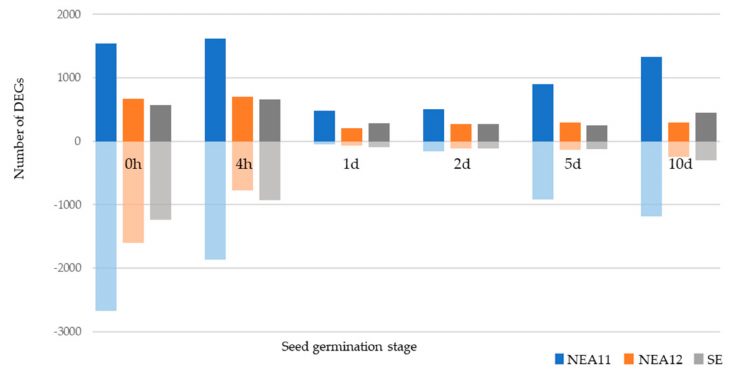
Figure 4. Number of DEGs of SE, NEA11, and NEA12 at different stages of seed germination during early stages of symbiotum establishment. The numbers of upregulated genes are shown in darker colour and downregulated in lighter colour.